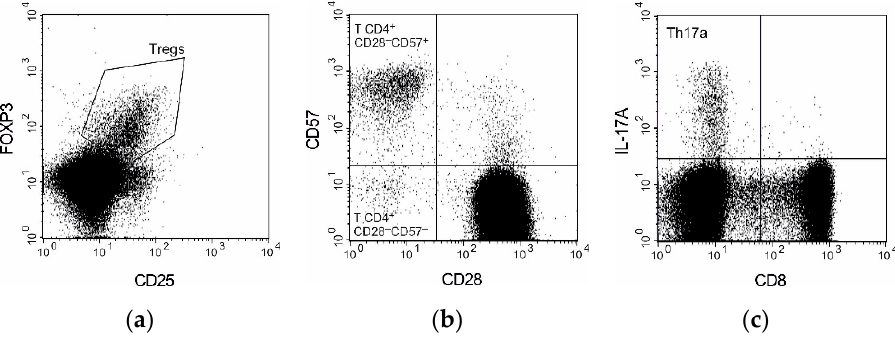
Figure 1. T subpopulations gating strategy. ( a ) Regulatory T cells gated on CD4 + T lymphocytes; ( b ) CD28-negative subpopulations gated on CD4 + T lymphocytes; ( c ) Th17a cells gated on T lymphocytes.